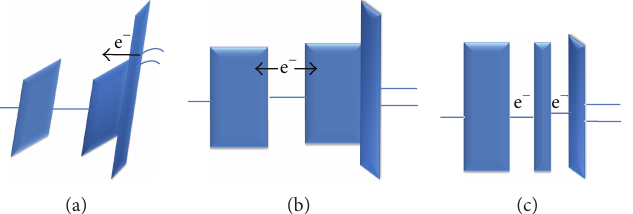
Figure 10: Energy band diagrams of a conventional structure (a) during programming and (b) during retention status and (c) multinano- crystals retention.